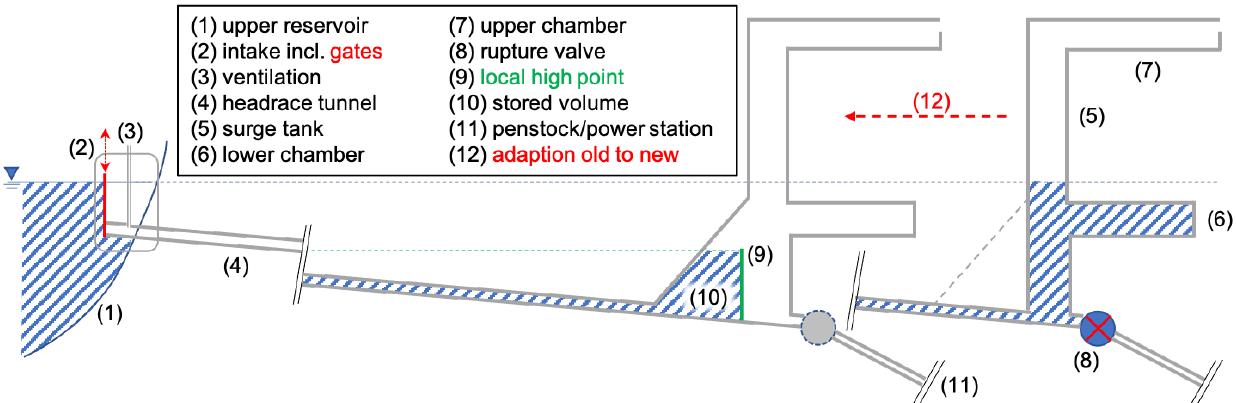
Figure 2. Sketch of upper part of a power plant comparing the original (right side) and adapted version, which only uses the intake gates—the additional needed excavation is indicated by a grey dashed line—horizontal dashed lines indicated water levels.